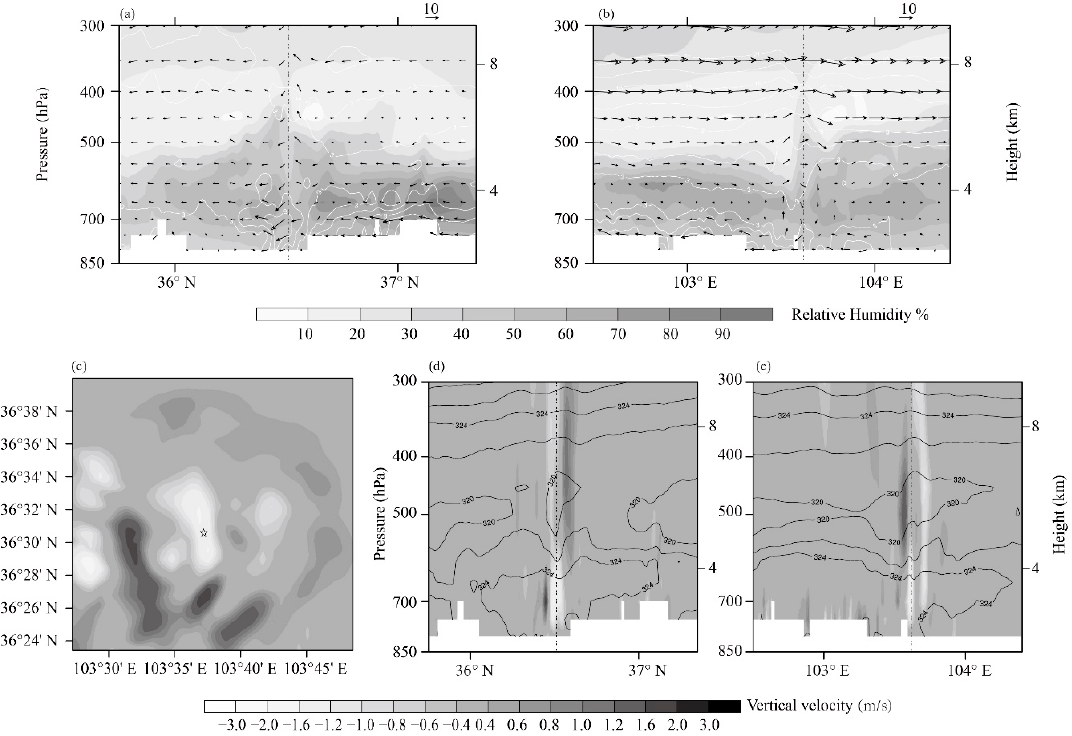
Figure 8. Latitude ( a ) and longitude ( b ) pressure cross-sections of the wind vector and speed (white line; m / s), RH (shaded; %). Horizontal distribution of vertical velocity ( c ) at 700 hPa. Latitude ( d ) and longitude ( e ) pressure cross-sections of the vertical velocity (shaded; m / s) and pseudo-equivalent potential temperature θ se (contour; K) at 11:30 UTC from the experiment DL10mL60Cycle. The five-pointed star indicates the site of ZLLL and the vertical velocities are magnified five-fold to visualize the vertical